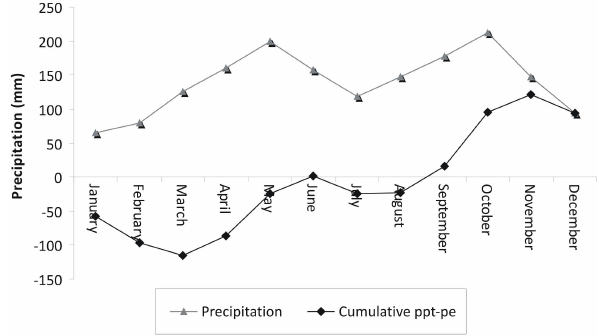
Fig. 8. The average monthly precipitation calculated over a 30- year period (1971–2000) (WMO) and the accumulative difference between the monthly average precipitation and evaporation, as pro- vided by